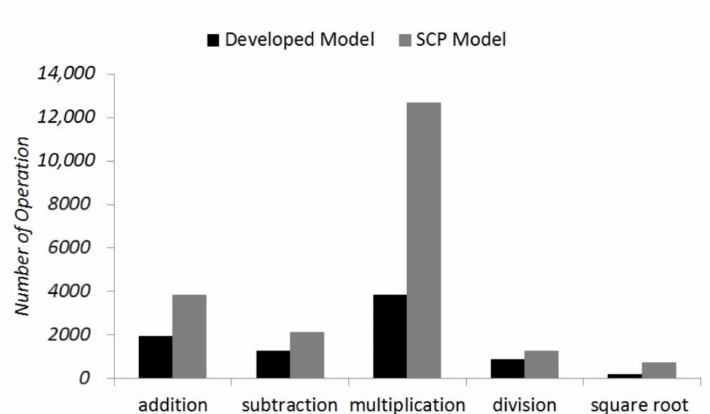
Figure 11. Executed operation numbers for models in the 34 bus test system